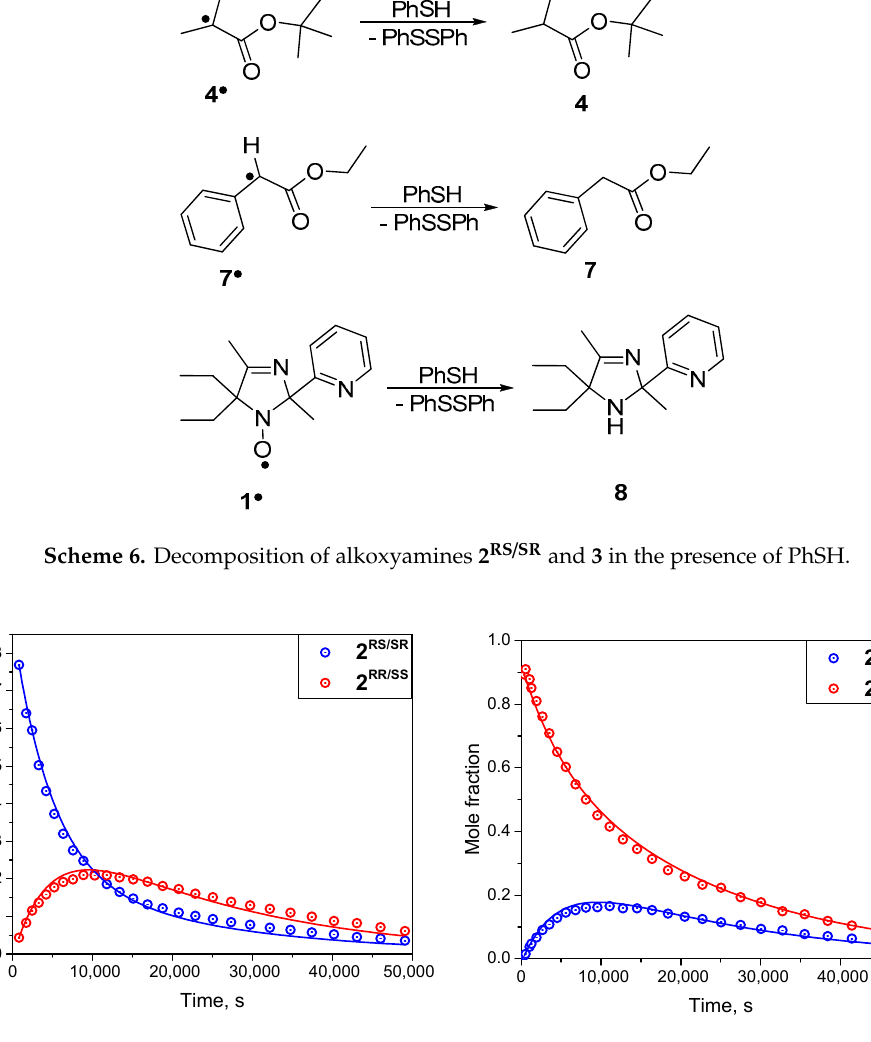
Figure 8. Kinetic curves of alkoxyamines decomposition of 2 RS/SR and 2 RR/SS at 347 K in toluene-d 8 in the presence of spin trap PhSH.